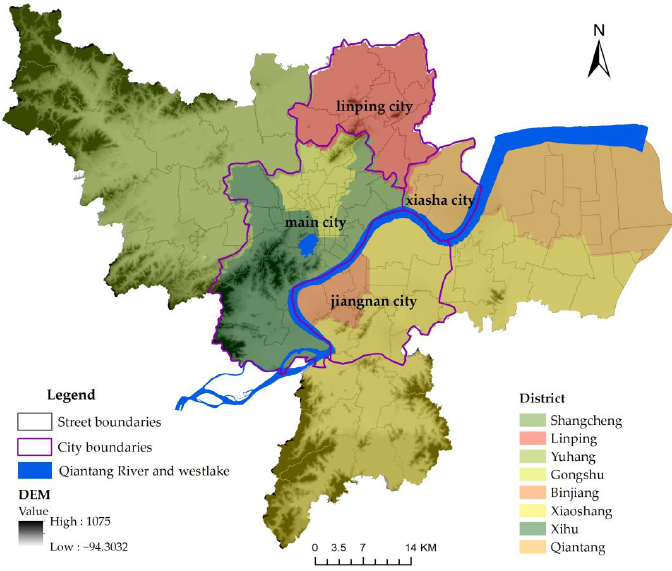
Figure 2. The study areas of Hangzhou.